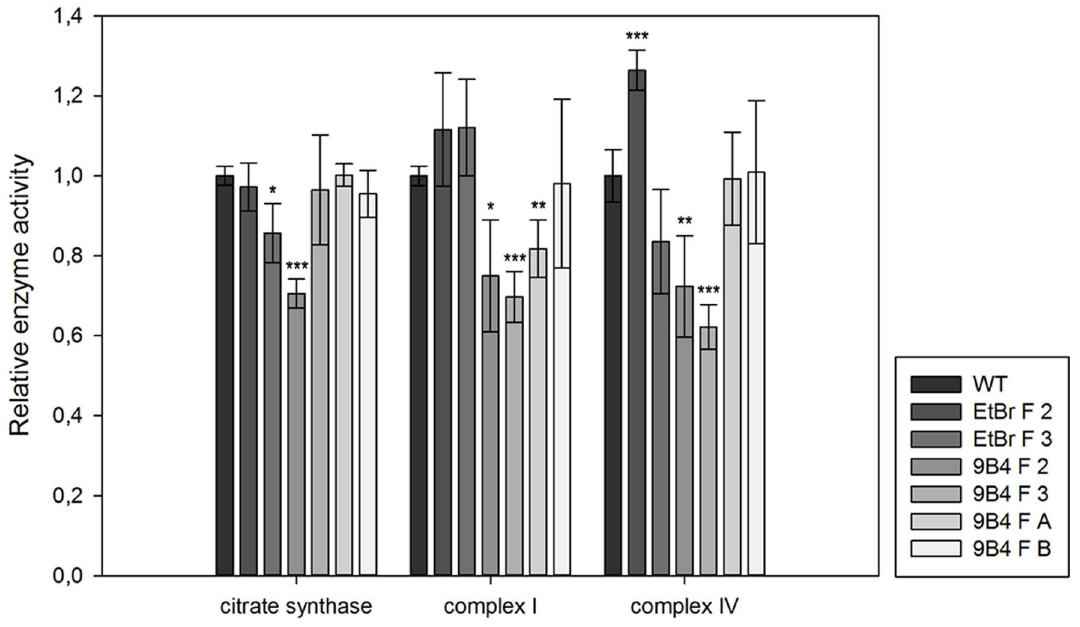
Figure 6. Activity of mitochondrial enzymes in PC-3 fusion cells. Enzyme activity of mitochondrial citrate synthase, respiratory complex I and IV was measured spectrophotometrically in total cell lysates and normalized to wild type. The data represent means 6 SD from four independent experiments. *P , 0.05, **P , 0.01, ***P , 0.001. Specific activity means of mitochondrial enzymes are shown in Table S1.